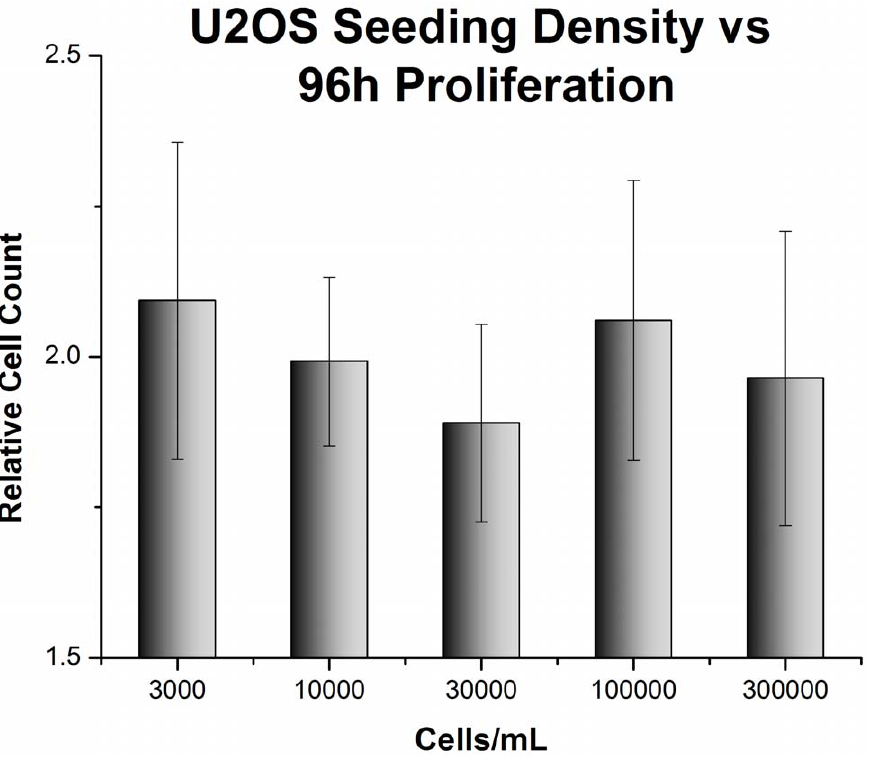
Figure 2. U2OS cell proliferation is unaffected by seeding density. U2OS cells were seeded at various densities in 300 m L collagen gels. Cells were imaged immediately after seeding and 96 hours later. Data is presented as a ratio of the cell population after 96 hours to the cell population at initial seeding.